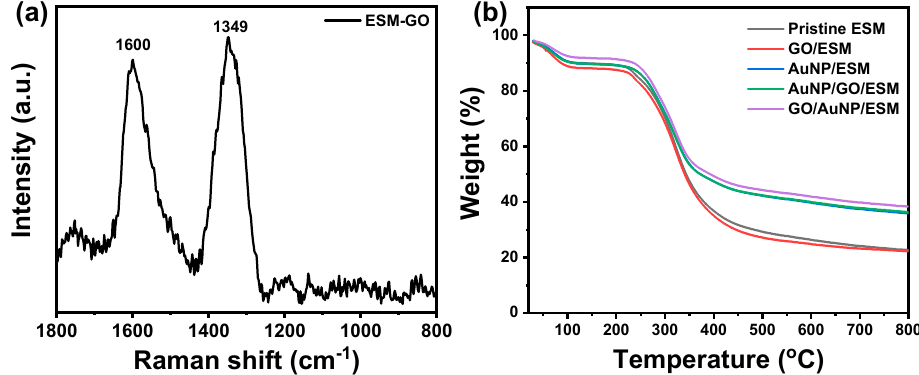
Figure 5. ( a ) Raman scattering spectrum of GO / ESM. ( b ) TGA curves of di ff erent ESM